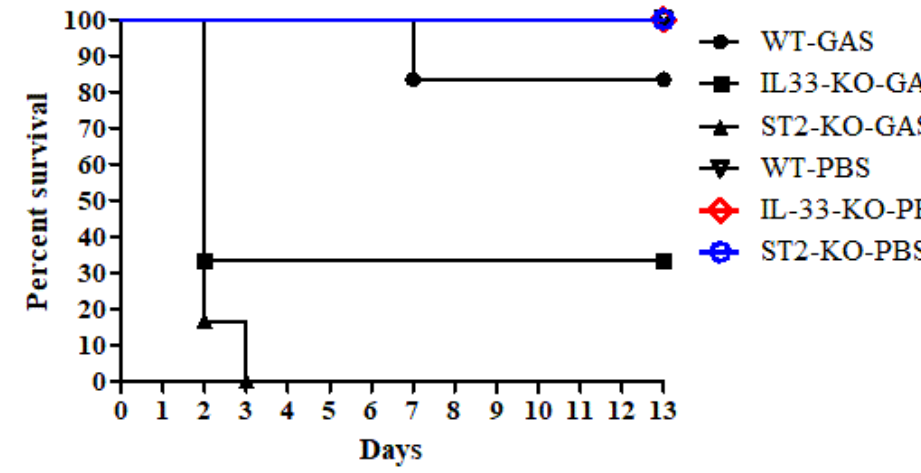
Figure 1. Increase in GAS-induced mortality in IL - 33 -KO and ST2 -KO mice. Groups of six WT, IL - 33 -KO and ST2 -KO mice were inoculated via the intra-air pouch route with 3 × 10 8 S. pyogenes NZ131 cells per mouse. The animals were observed every day for a total of 13 days. Intra-air pouch injection of PBS would cause no mice death in WT, IL - 33 -KO and ST2 -KO mice. Survival curves were compared for significance using the logrank test on the GAS-infected ST2 -KO group vs. the GAS-infected B6 group ( p = 0.0005, p < 0.01), and on the GAS-infected IL - 33 -KO group vs. the GAS-infected B6 group ( p = 0.0417, p < 0.05).